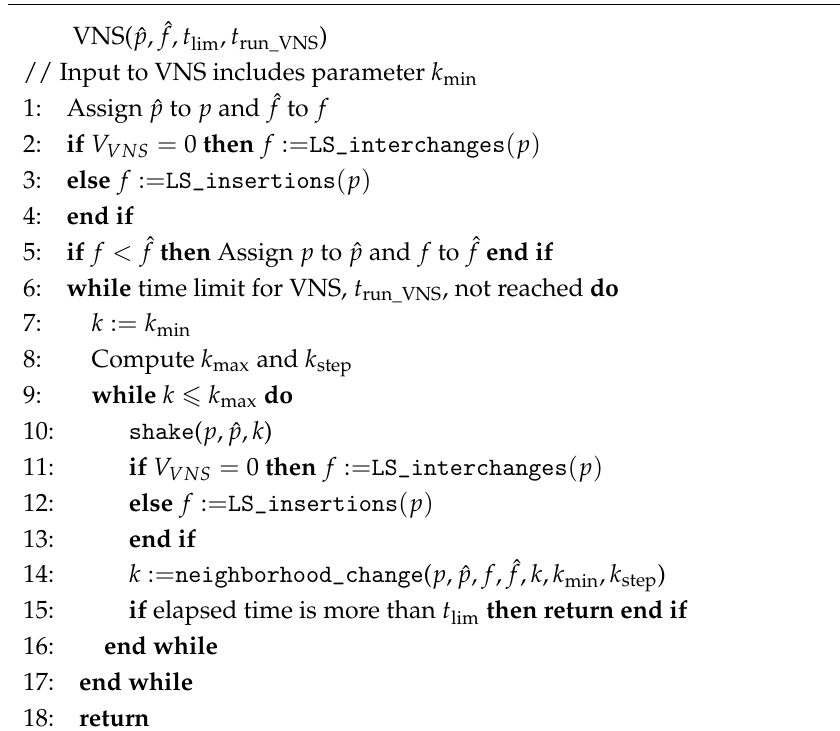
Algorithm 5 Variable neighborhood